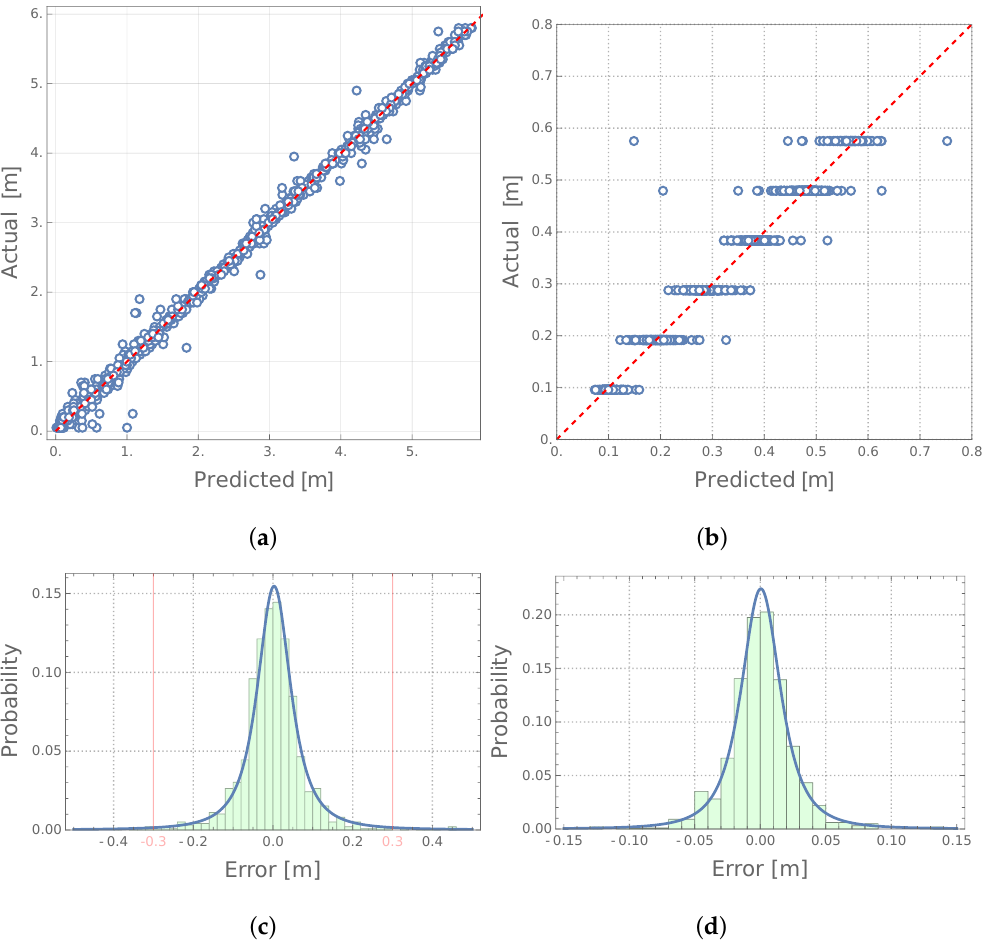
Figure 6. The results of identification of degradated zone: ( a , c )—location; ( b , d